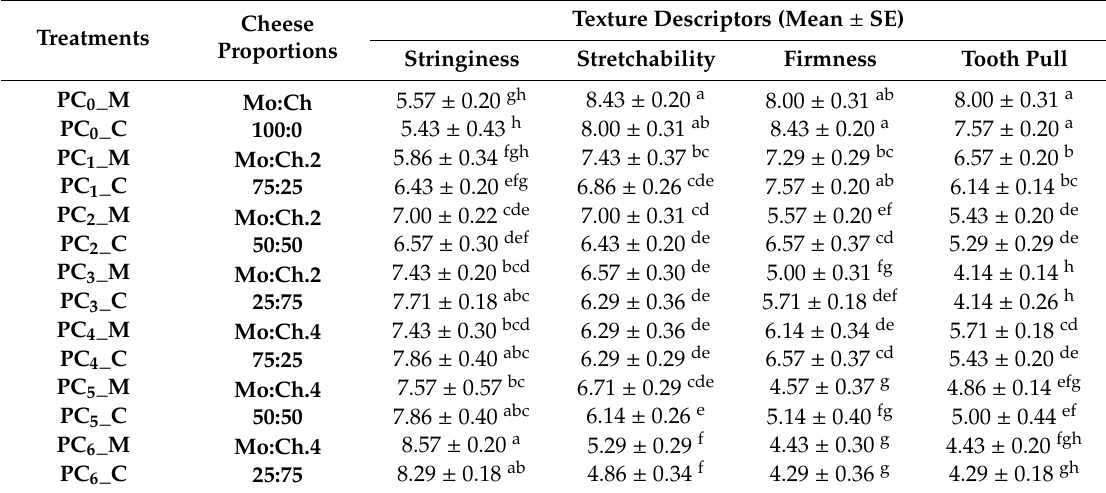
Table 4. E ff ect of proportion of cheeses, ripening time (months) of Cheddar cheese, and cooking methods on the texture descriptors of Pizza